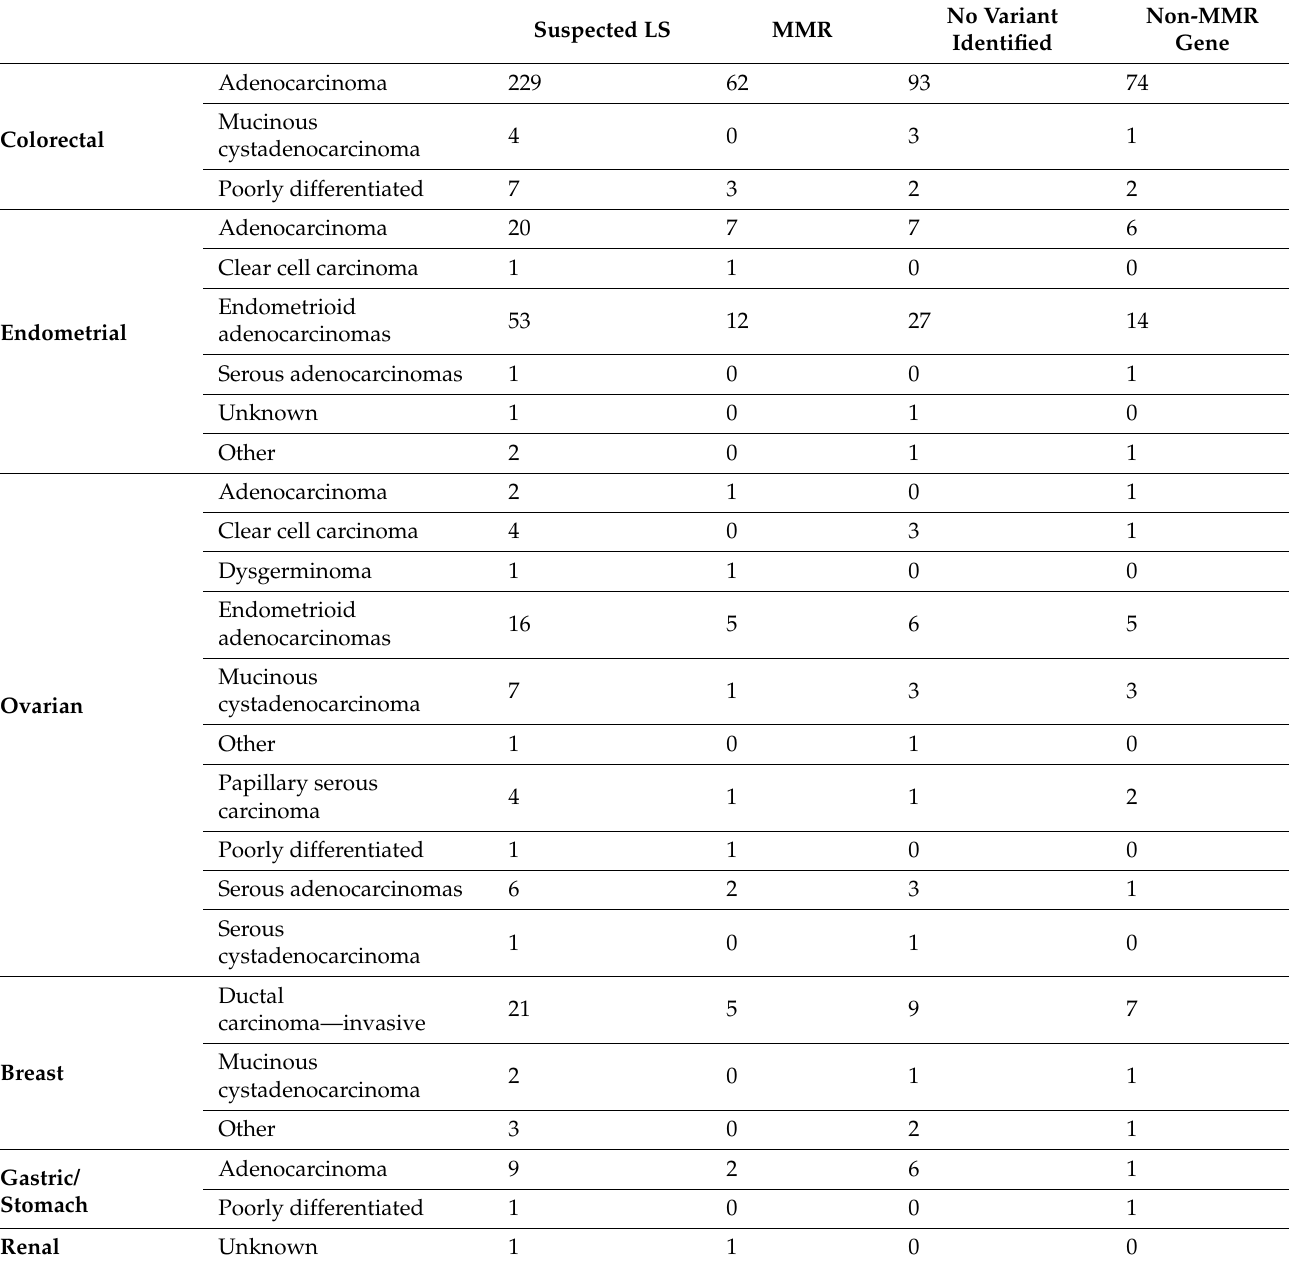
Table 3. Histological subtype by cancer type in patients with suspected Lynch syndrome, with MMR variant carriers, cases of no variant identified, and carriers of variants in non-MMR